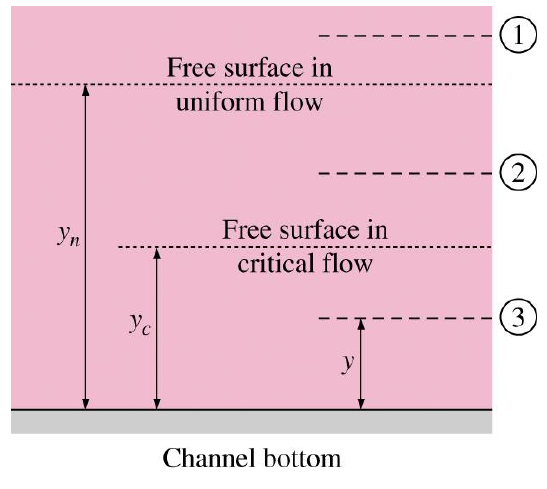
Figure 2. Channel